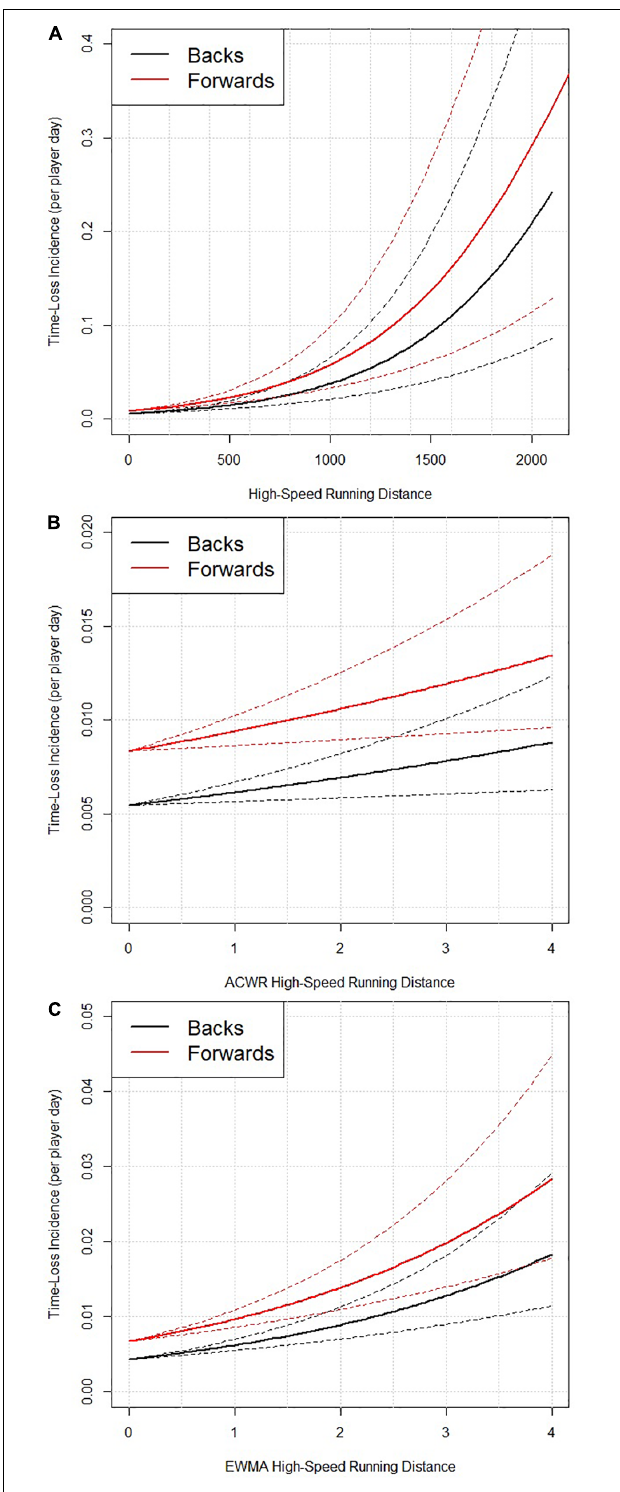
FIGURE 3 | The relationship between time-loss incidence occurrence (per player day) and absolute high-speed running distance ( p < 0.001) (A) , ACWR high-speed running distance ( p = 0.154) (B) , and EWMA high-speed running distance ( p = 0.002) (C) , split for backs and forwards. Data are mean ± standard